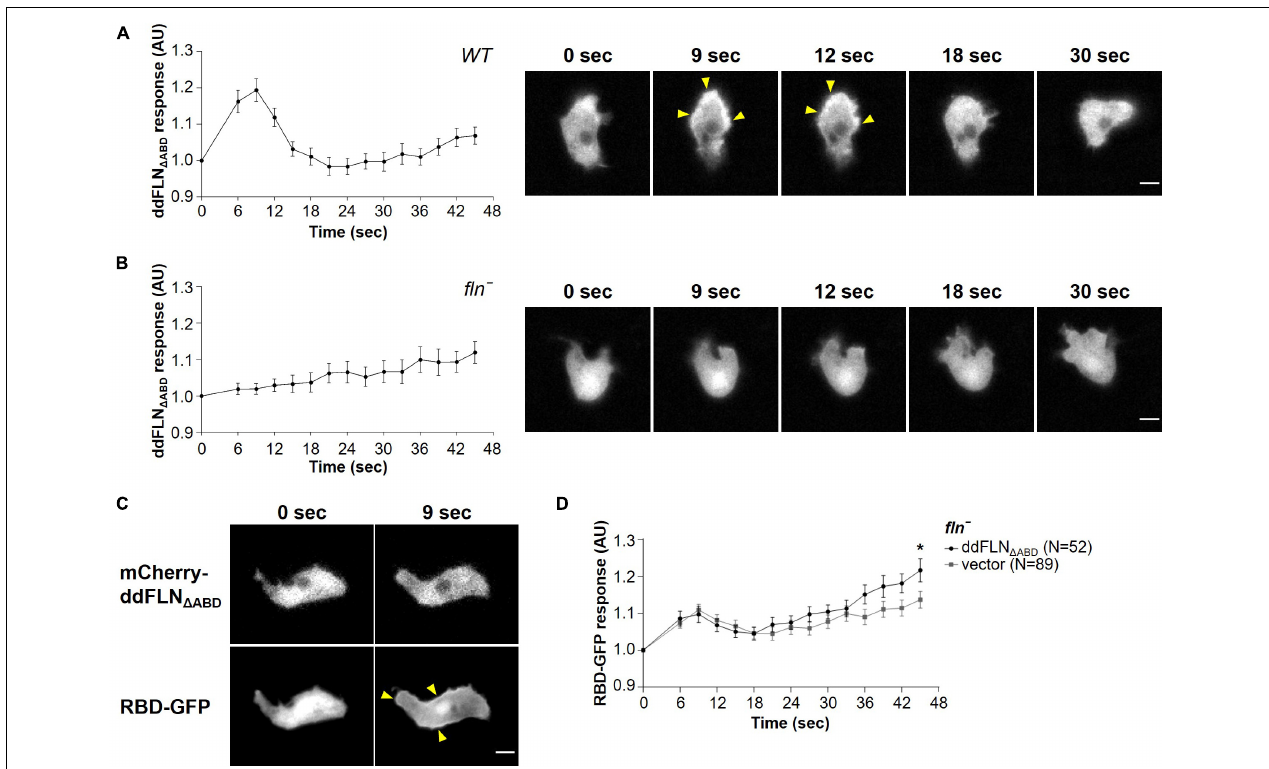
FIGURE 5 | Filamin’s actin-binding domain is required for its role in shear flow-induced response. (A–C) Wild-type (WT) (A) or fln - (B) cells expressing RBD-GFP and mCherry-tagged ddFLN (cid:49) ABD were imaged every 3 s by epifluorescence microscopy with an RFP filter set under 630X magnification with oil immersion. Shear flow (45 dyn/cm 2 ) was applied at time 0 for 2 s. Response was measured as protein relocalization from the cytosol to the cell cortex. Data is displayed as mean ± SE of 42 (A) or 30 (B) cells pooled from two independent experiments. A representative cell is shown to the right of the graph. (C) A representative fln - cell expressing RBD-GFP and mCherry-tagged ddFLN (cid:49) ABD is shown to demonstrate the lack of ddFLN (cid:49) ABD translocation even in cells that have robust RBD-GFP recruitment to the cortex. Arrowheads point to biosensor accumulation at the cortex. Scale bar, 5 µ m. (D) Activation of Ras, which reflects activation of the signal transduction network, was measured by the relocalization of RBD-GFP from the cytosol to the cell cortex in fln - cells expressing RBD-GFP and either mCherry-tagged ddFLN (cid:49) ABD or empty vector. Cells were imaged as above with a GFP filter set every 3 s and stimulated with 2 s of shear flow (45 dyn/cm 2 ) at time 0. Data is displayed as mean ± SE. Number of cells analyzed is provided in the key and was pooled from three independent experiments. * P <